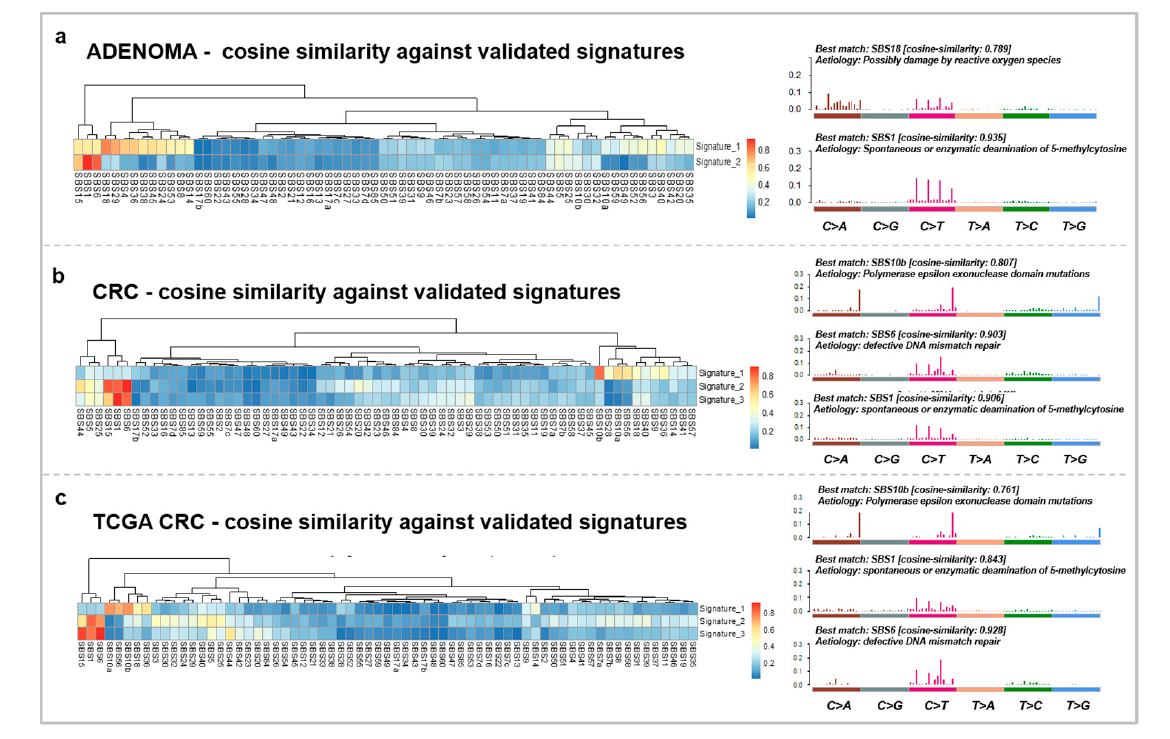
Figure 2. Somatic mutation signatures of the adenomas ( a ) and carcinomas of our cohort ( b ) and the TCGA COAD + READ CRC ( c ) dataset. The left panels represent the signatures retrieved from the analyzed groups and their similarity to the COSMIC v3.2 SBS signatures on heatmaps. The right panels show the characteristic signatures of the datasets and the proposed etiology of the SBS sig- natures.